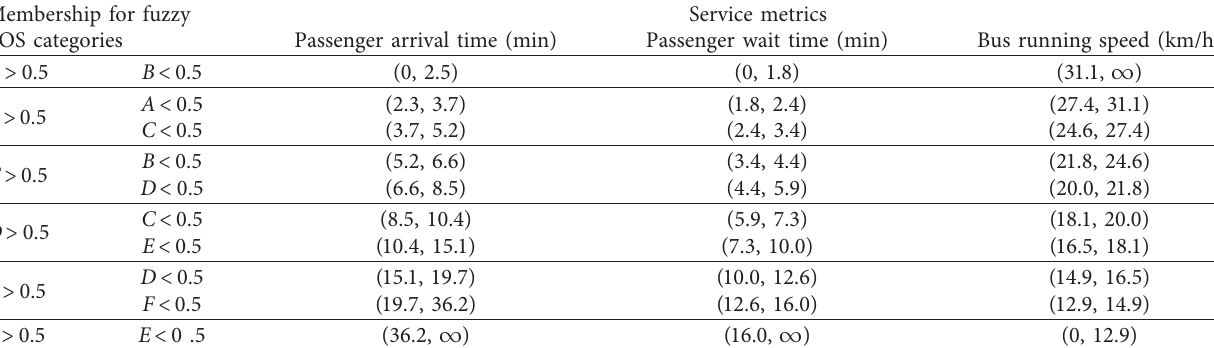
Table 5: BRT fuzzy LOS criteria for the anxious passenger group (ranges of service metrics for one primary and one secondary LOS category).